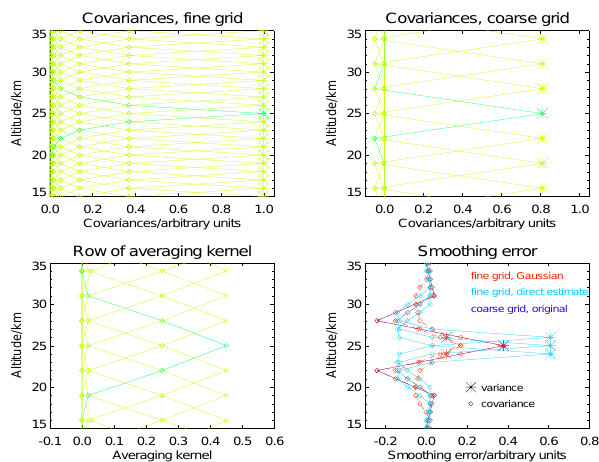
Figure 1. Case study: the upper left panel shows the ensemble co- variances on the fine grid (grid spacing 1km). Only the symbols are significant – the lines are only plotted to guide the eye. The large asterisks are the variances. The variance and covariances referring to 25km are highlighted for clarity. The top right panel shows the covariances on the coarse (grid width 3km) grid. The lower left panel shows the averaging kernels on the coarse grid. The lower right panel shows the estimated smoothing errors (in terms of vari- ances/covariances) at 24, 25 and 26km altitude: the smoothing er- rors on the fine grid estimated by Gaussian error estimation (red) are largest at 25km, an altitude which coincides with an altitude of the coarse grid, and are smaller for 24 and 26km, where the values on the fine grid depend on interpolation. The opposite is true for the direct estimates of the smoothing error on the fine grid (light blue): here the smoothing error is smallest at 25km and larger at 24 and 26km. More importantly, the directly estimated smoothing errors are considerably larger. This is because the relevant ensemble co- variance matrix contains larger atmospheric variability (cf. top pan- els). The original smoothing error estimate on the coarse grid (dark blue) is hardly visible because it is identical to that represented on the fine